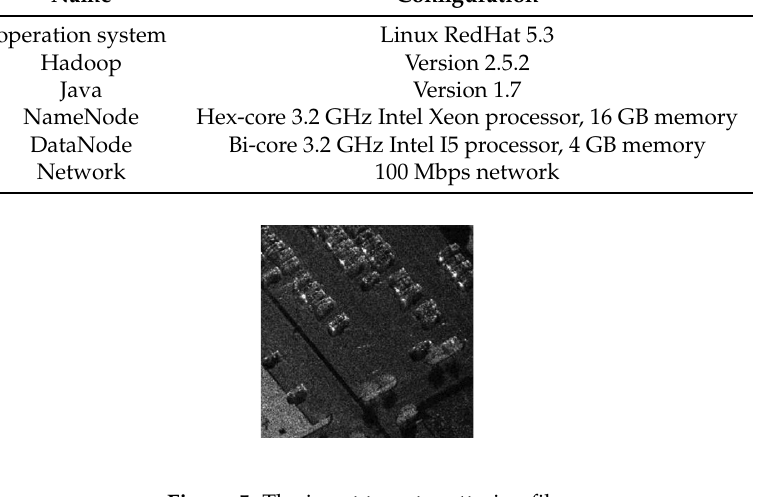
Figure 5. The input target scattering file. Table 2. Experimental algorithms.